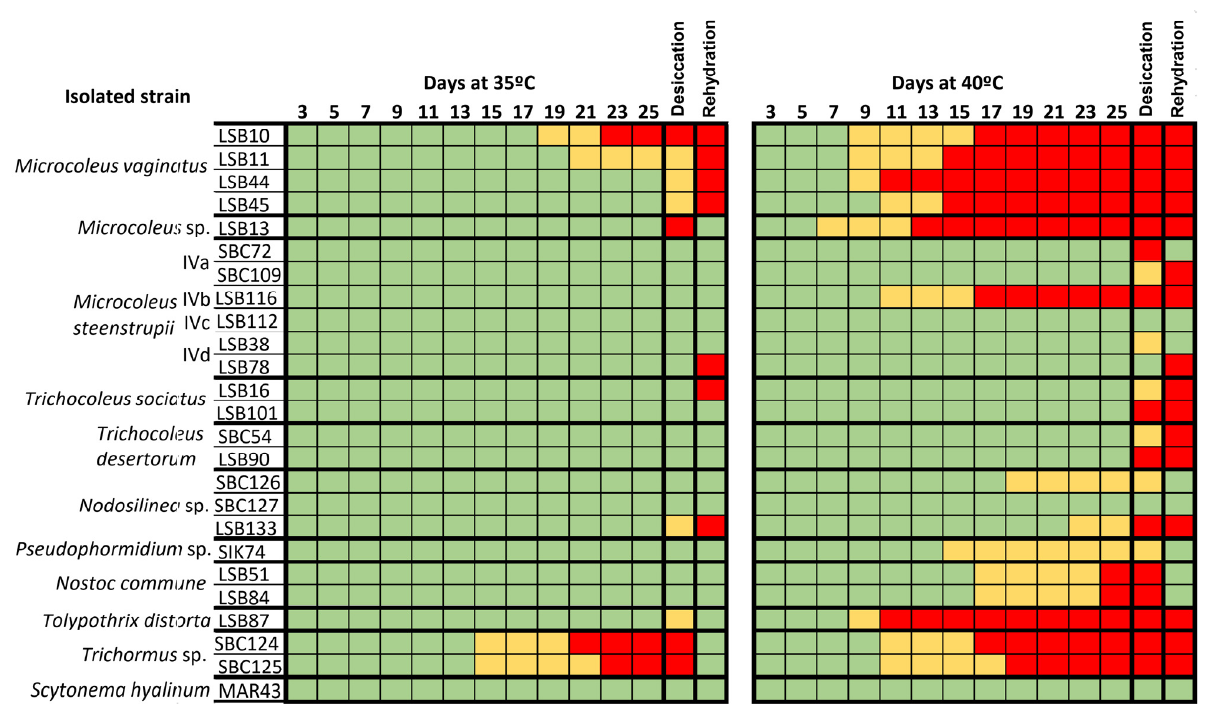
Figure 8. Survival of cyanobacterial cultures over 25 days at 35 and 40 °C, subsequent response of cultures to two months- long desiccation treatment at 35 and 40 °C, and later survival following the addition of culture medium to the desiccated cells and maintained at room temperature. Green-coloured rectangles indicate survival, orange-coloured rectangles indicate some deterioration with initial loss of pigmentation, and red-coloured rectangles indicate death.